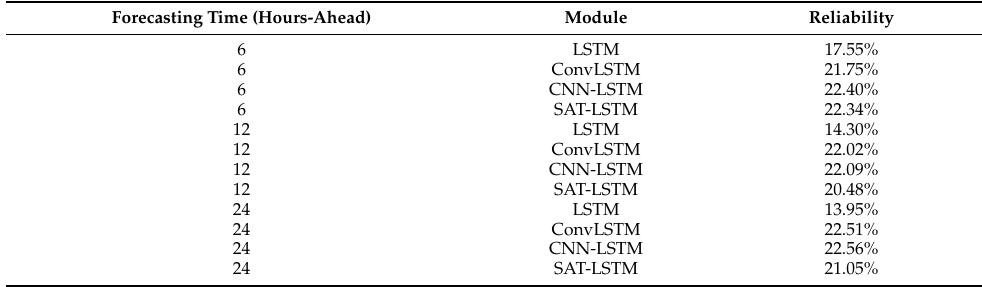
Table 6. The reliability for the proposed models. Forecasting Time (Hours-Ahead)